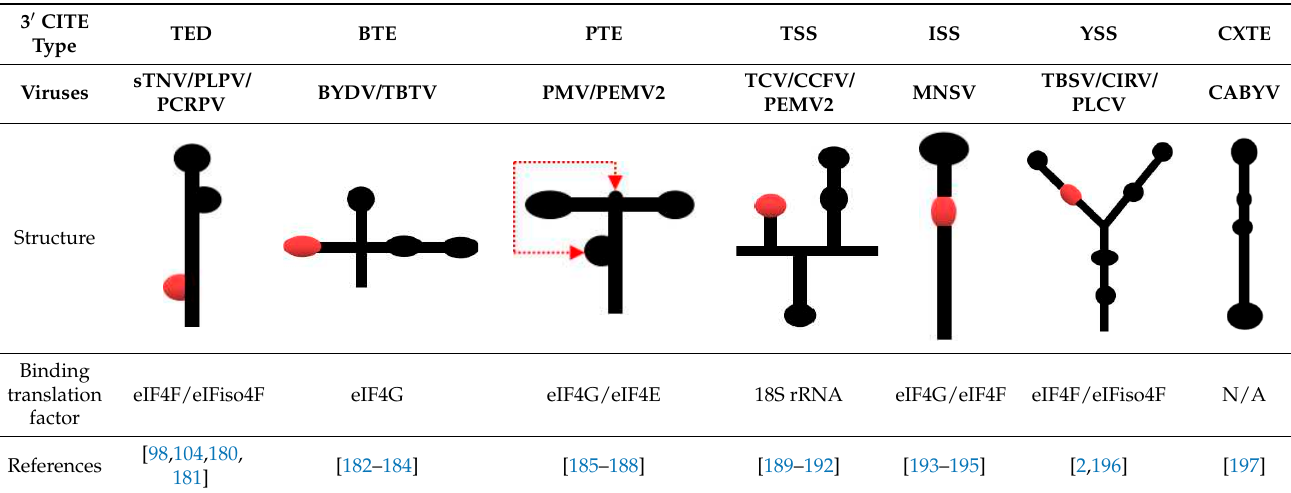
Note: sTNV, satellite tobacco necrosis virus; PLPV, pelargonium line pattern virus; PCRPV, pelargonium chlorotic ring pattern virus; BYDV, barley yellow dwarf virus; TBTV, tobacco bushy top virus; PEMV2, pea enation mosaic virus RNA 2; TCV, turnip crinkle virus; CCFV, cardamine chlorotic fleck virus; CABYV, cucurbit aphid-borne yellows virus; TBSV, tomato bushy stunt virus; CIRV, carnation Italian ringspot virus; PLCV, pelargonium leaf curl virus; MNSV, melon necrotic spot virus; N/A, not analyzed. Red part in RNA structures indicates the RNA cis -elements bound by corresponding translation initiation factors.